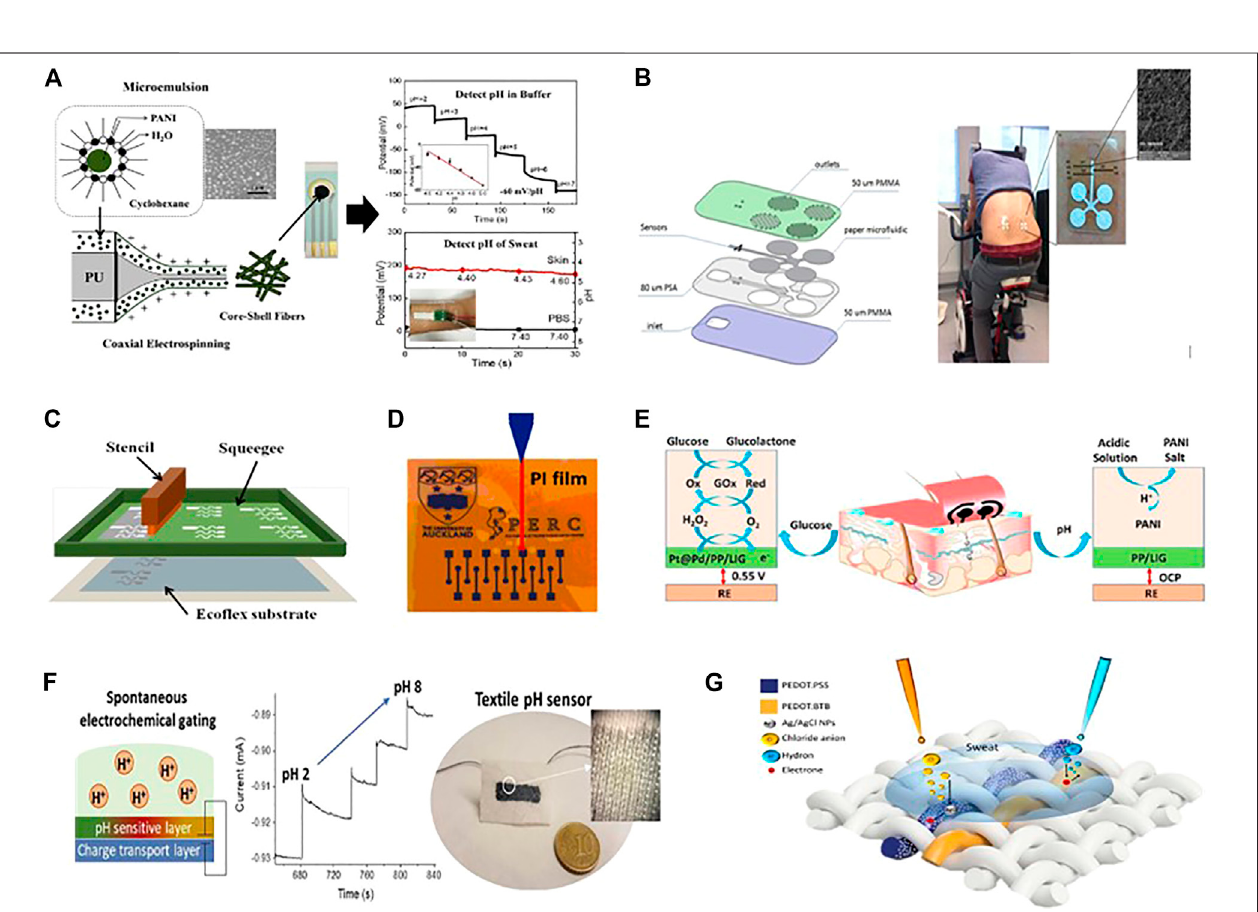
FIGURE5|(A) Fibercoaxialelectrospinningwithgraphmonitor,pHdeterminationinbuffer,andsweat(Copyright2020;Polymers&Biopolymers). (B) Aschematic representation of the micro fl uidic chip fabrication steps is seen, as well as a photograph of the platform attached to the body and an image from scanning electron microscopy (SEM) (Copyright 2017; Biosensors and Bioelectronics). (C) Screen-printed stretchable device with custom stretch-resistant (Copyright 2015; Wiley). (D)